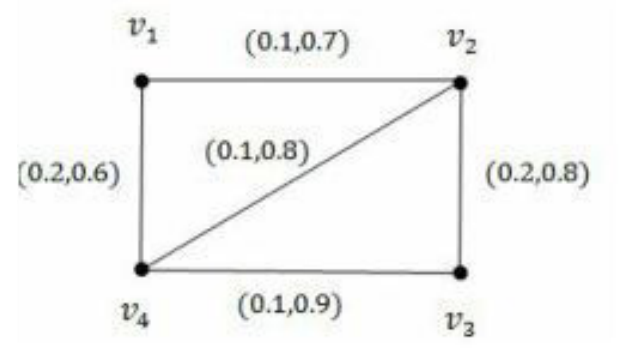
Figure 15. VG ( G 3